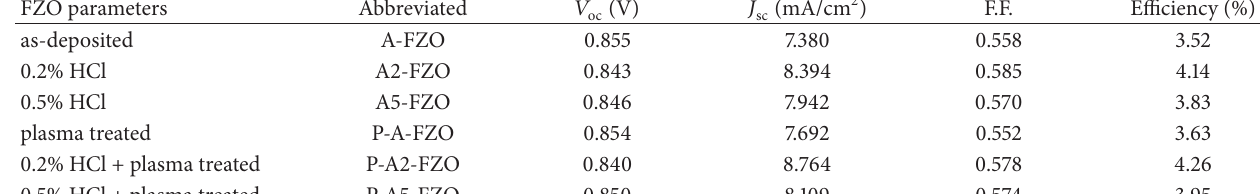
Table 1: 𝑉 value, 𝐽 value, and F.F. value of the fabricated amorphous silicon thin film solar cells. oc sc